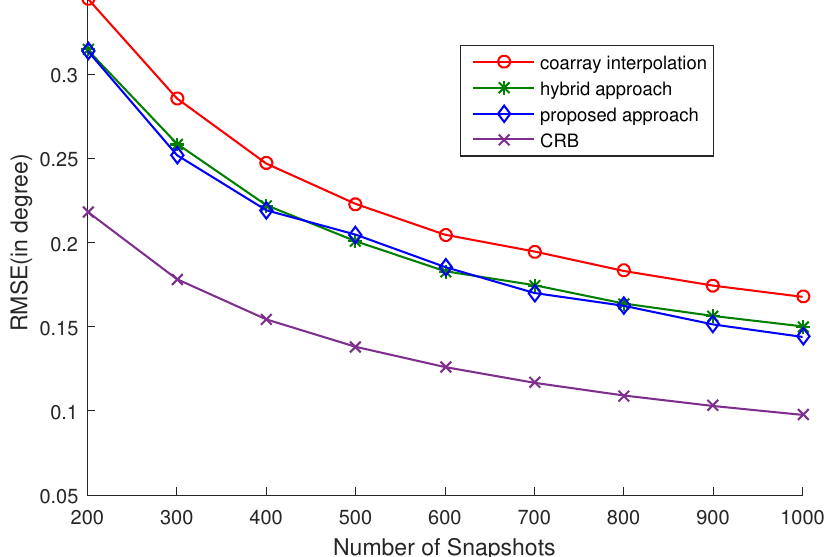
Figure 3. RMSE vs. the number of snapshots. Five hundred Monte Carlo trials are conducted and Q = 16 sources uniformly distributed in [ − 50 ◦ ,50 ◦ ] are considered. The SNR is 0 dB and the selection of (cid:101) is listed in Table 3. Table 2. (cid:101) with respect to different numbers of snapshots.